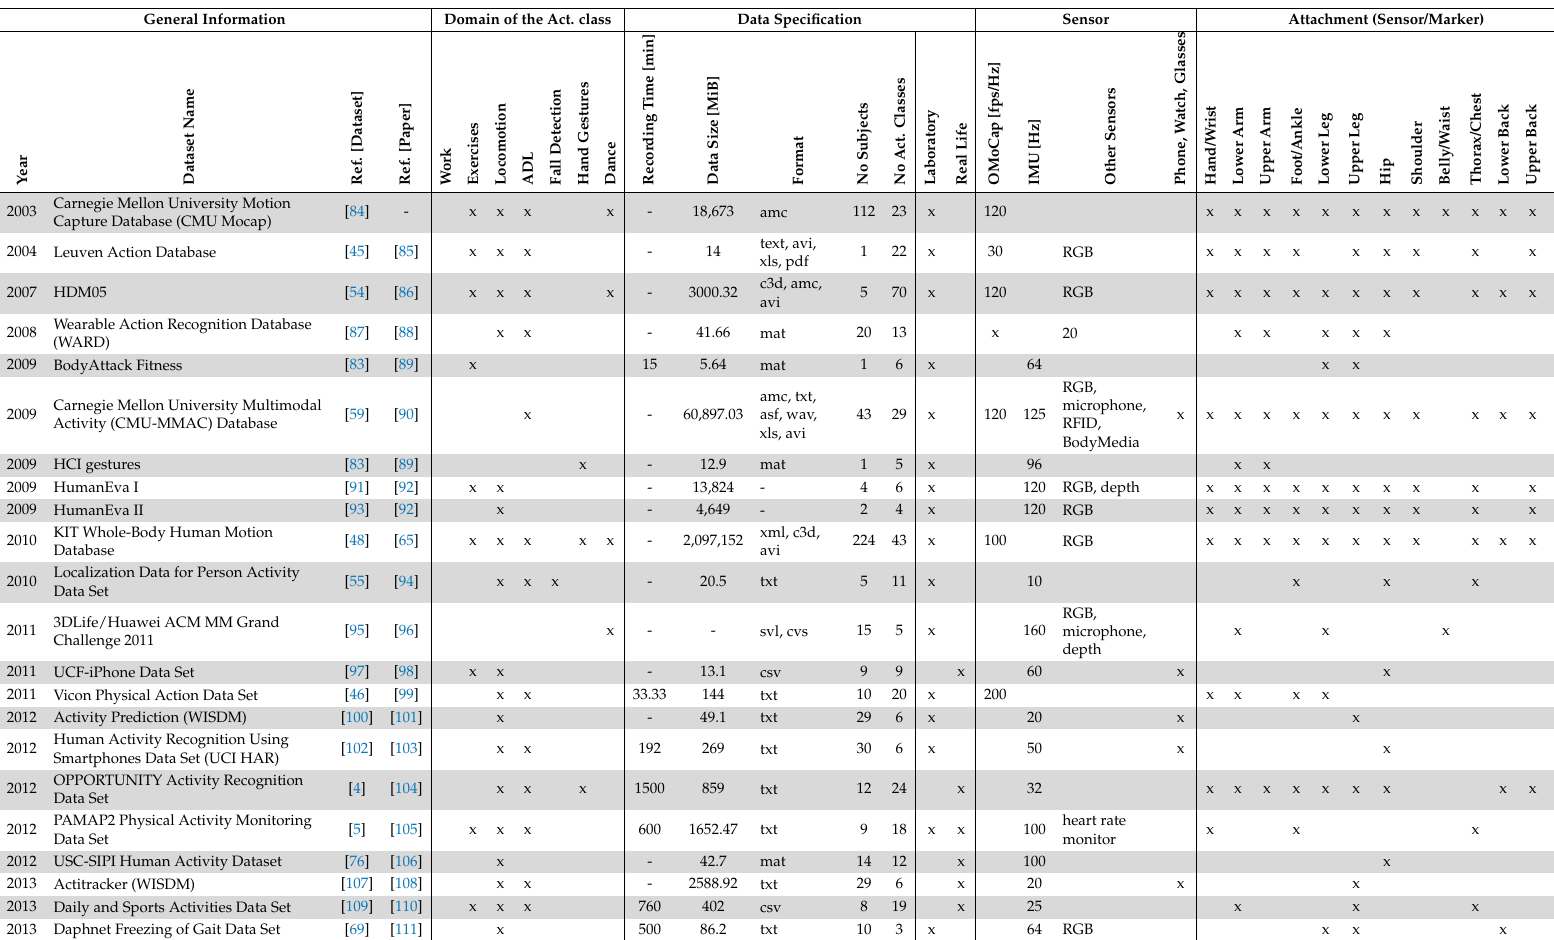
Table A4. Overview of related public available human activity recognition datasets. The entries are sorted chronologically in ascending order according to the year of publication and alphabetically according to the name of the dataset. Missing informations are marked with